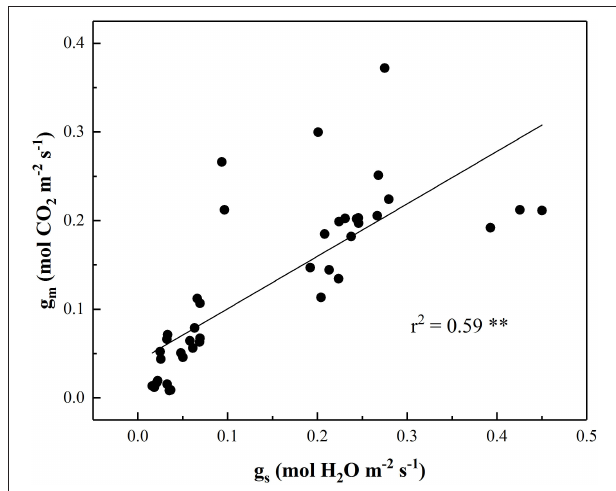
FIGURE 5 | The relationship between the stomatal conductance to H 2 O (g s , mol H 2 O m − 2 s − 1 ) and mesophyll conductance to CO 2 (g m , mol CO 2 m − 2 s − 1 ) in the leaves under progressive drought. Data were fitted by a linear regression with r 2 = 0.59 at P < 0.01